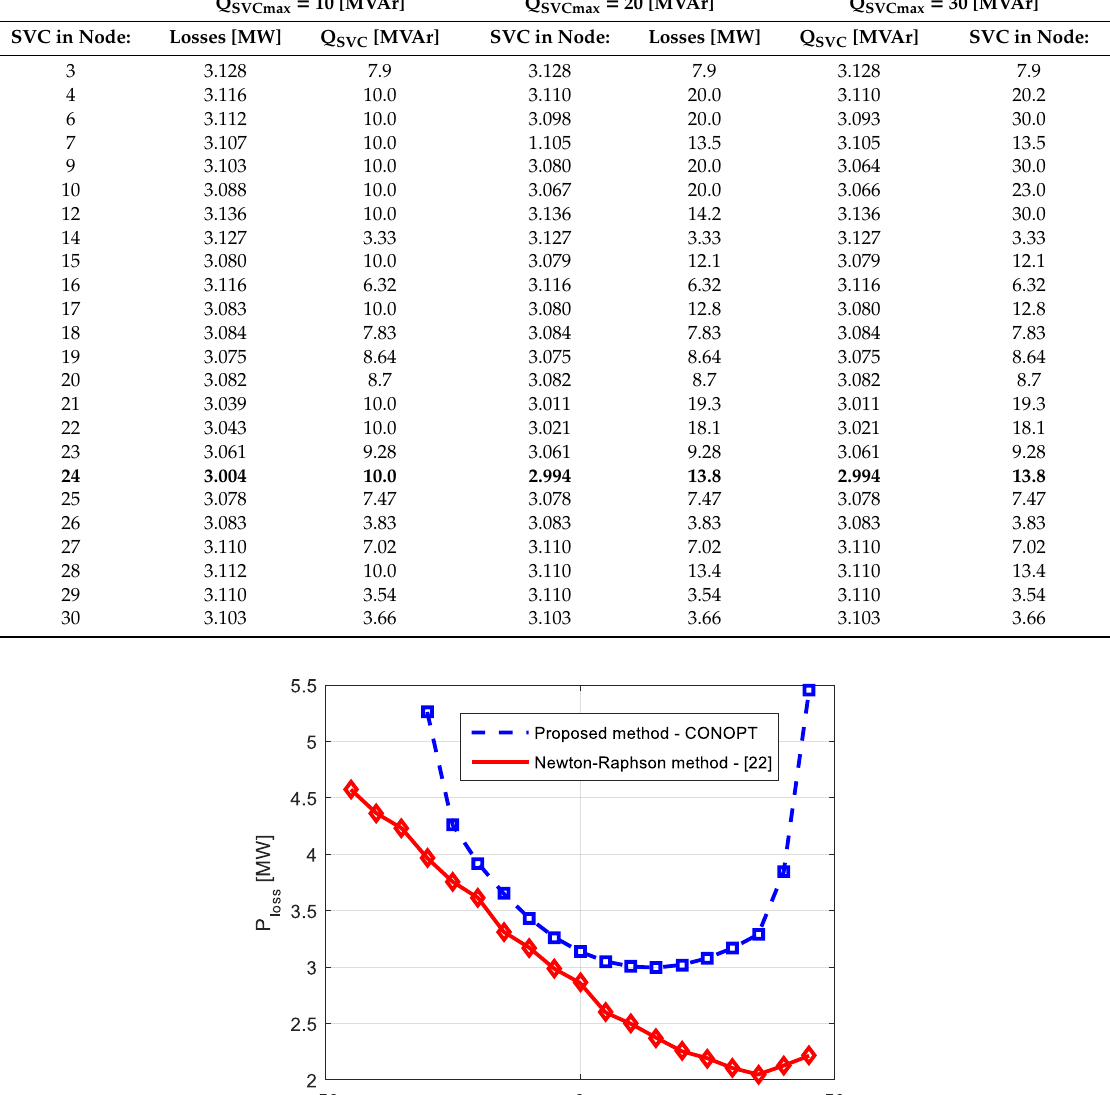
Table 5. Power losses (MW) with SVC in the IEEE 30 test bus system with a limited value of Q SVC —CASE 1. Q SVCmax = 10 [MVAr] Q SVCmax = 20 [MVAr] Q SVCmax = 30 [MVAr]